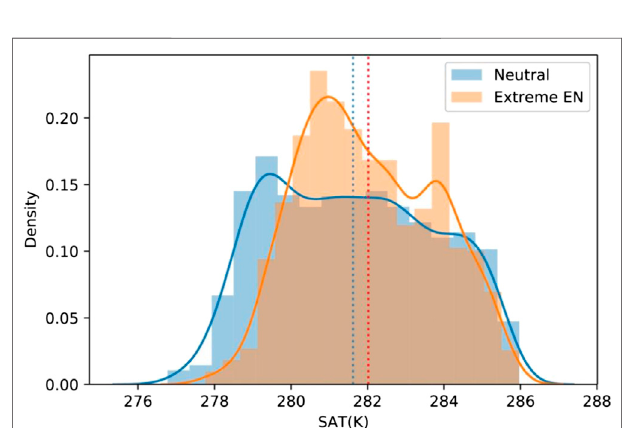
FIGURE 3 | Probability distribution functions (PDFs) of regional mean SAT in North America in spring. Dashed black and solid red lines indicate PDFsforSATforneutralENSOandextremeENevents,respectively.ThePDF for extreme EN isstatistically different tothat forneutral ENSO (based on a Kolmogorov-Smirnov test; p < 0.01). Figure for the moderate EN case with no obvious response were omitted.